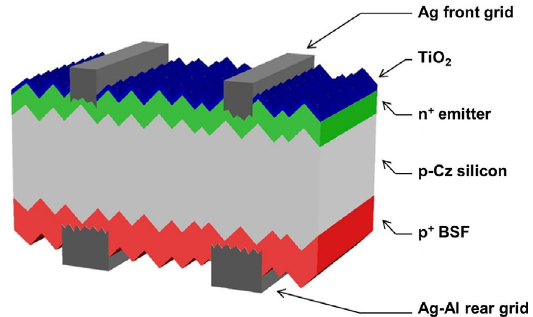
Figure 2. Structure of TiO